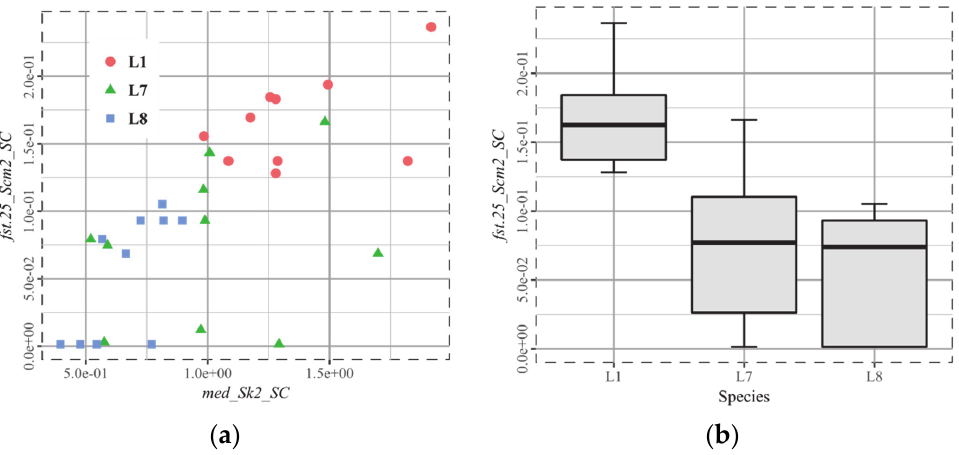
Figure 12. Ewes fed on ray grass and mature grass, most discriminating parameters. ( a ) The topology parameters Scm2 and Sk2 separate L1, (L7, L8) and to a slight degree L7, L8, respectively; and, ( b ) fst.25_Scm2_SC is statistically higher for L1 than for L7 and L8.